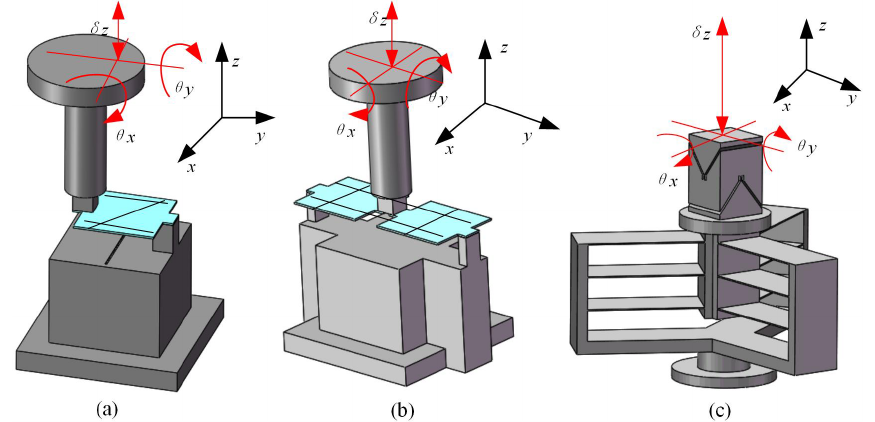
Figure 8. (a) L1 compliant suitable constrained branch. (b) L2 compliant suitable constrained branch. (c) PU compliant suitable constrained branch.